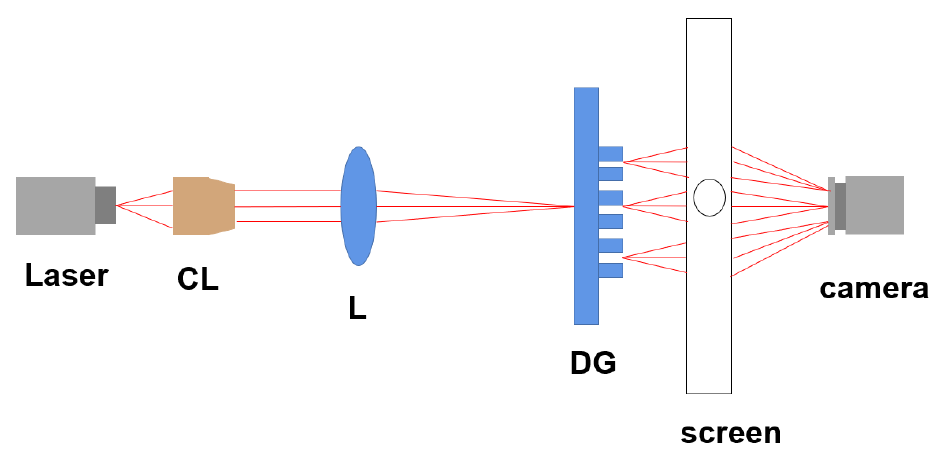
Figure 8. Schematic illustration of 3D sensing system. CL, collimation lens; L, lens.